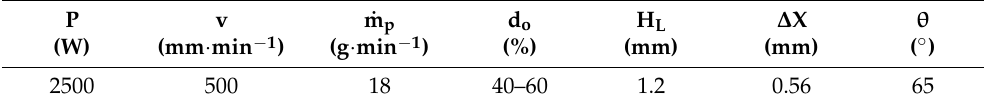
Table 2. Main deposition parameters.